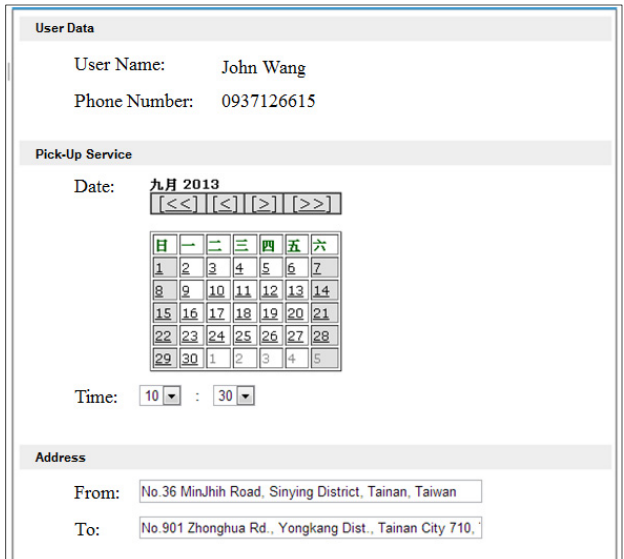
Figure 15. Pick-up web service settings